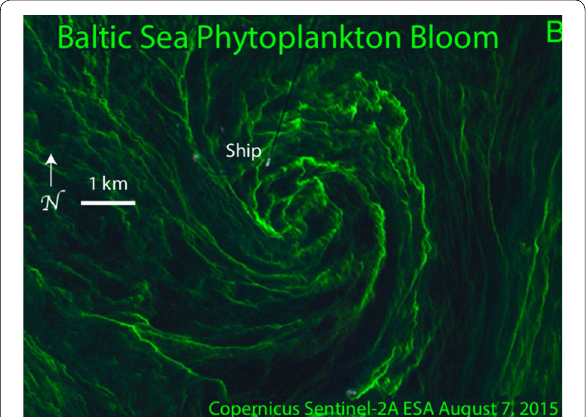
Fig. 5 Submesoscale surface vortex. A satellite image of plankton concentrated in surface convergence lines in the Baltic Sea. The lines indicate a submesoscale central cyclone with spiral arms that are dense filaments. A similar behavior is seen in a set of convergent surface drifter trajectories, first into an arm and then into the cyclone center, in the Gulf of Mexico (D’Asaro et al. 2018), but in a separate event from that depicted in Fig.